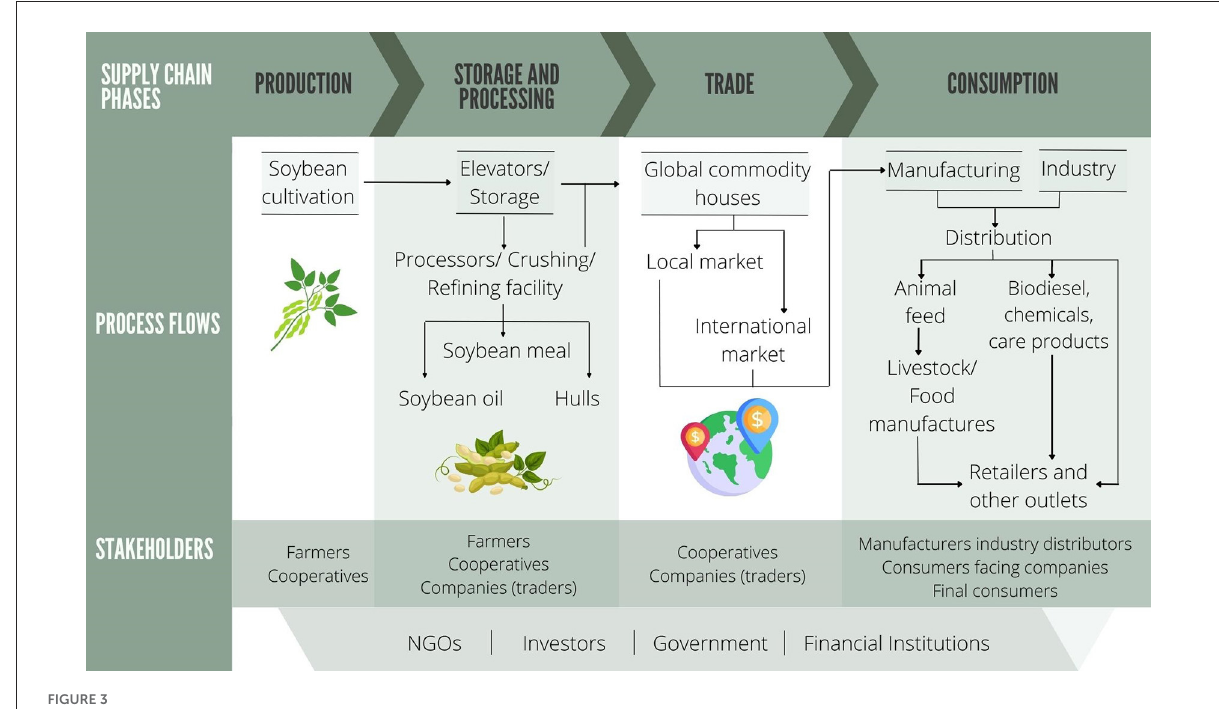
FIGURE3 Soy supply chain representation. Source: Adapted from Brack et al. (2016) and IDH and IUCN (2017).